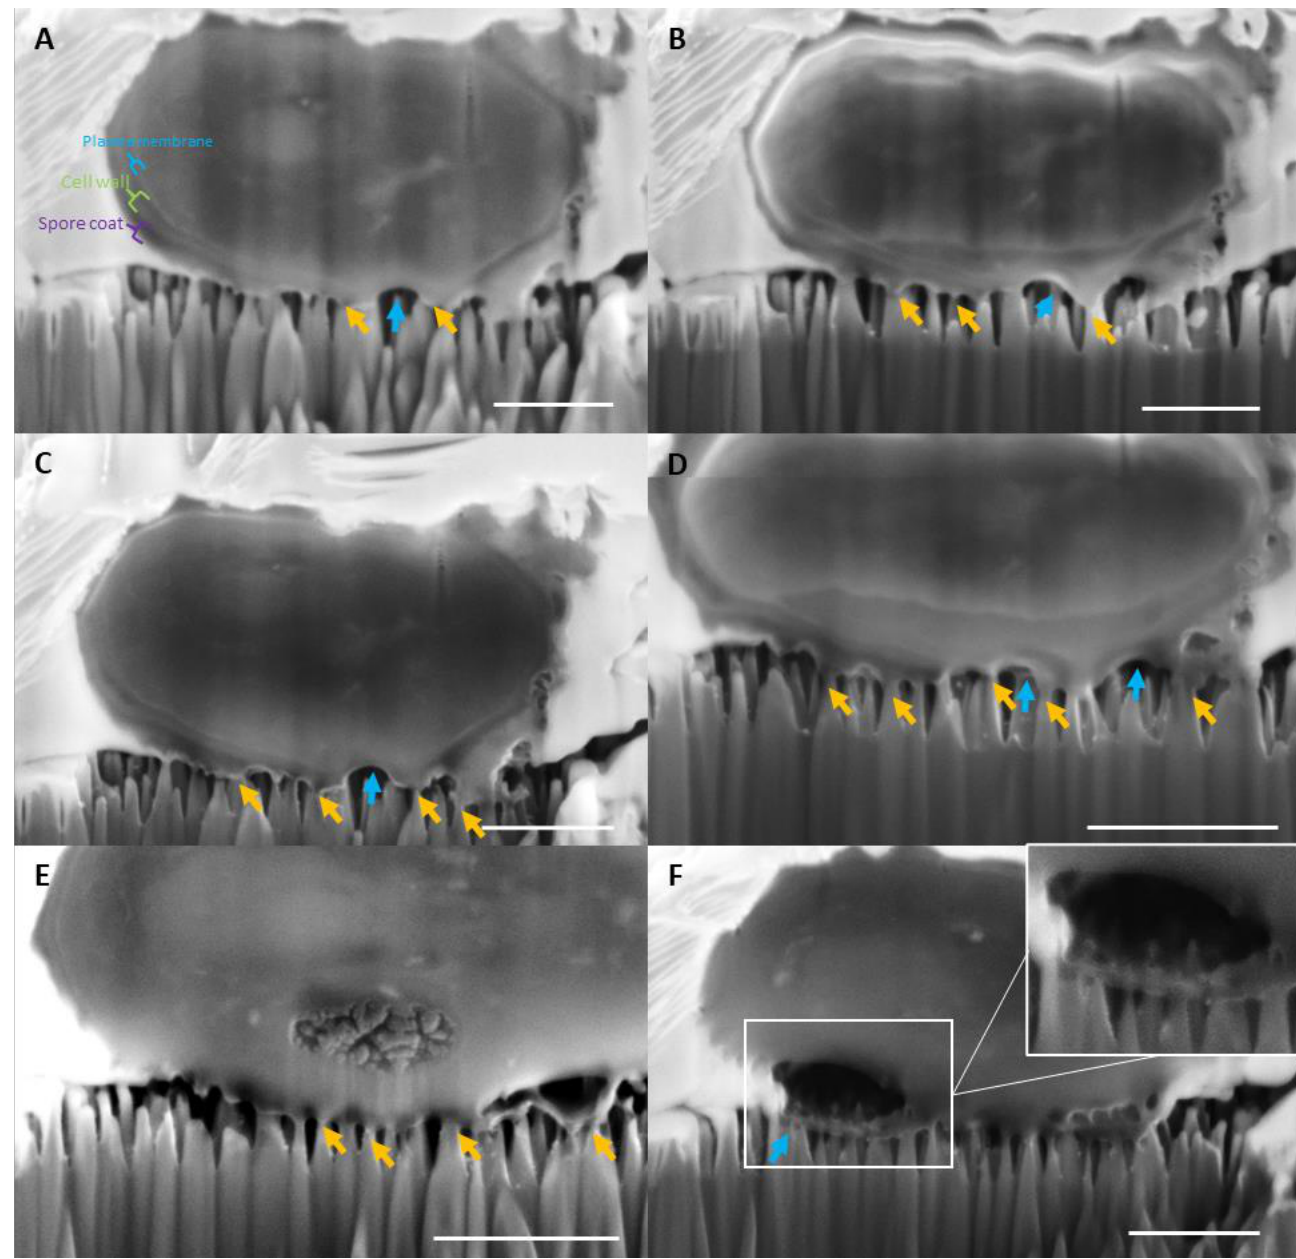
Figure 3. Sequential FIB milling of the spore-nanopillar interface on hydrophilic nSi surfaces. SEM micrographs show the adhesion of the spore coat to the nanopillars (orange arrows indicate direct comtact). ( A ) Breakage of the cell wall and inner plasma membrane is evident at the points between spore coat adsorption to the substratum surface (blue arrows indicate the lack of contact). ( B – E ) Consecutive micrographs show an increase in the number of nanopillars in contact with the cell and consequently greater deterioration of the cell wall and plasma membrane. ( F ) Cell lysis is confirmed by the occurrence of large holes in the body of the cell. Nanopillars are observed inside the cell. Scale bars are 1 µm.